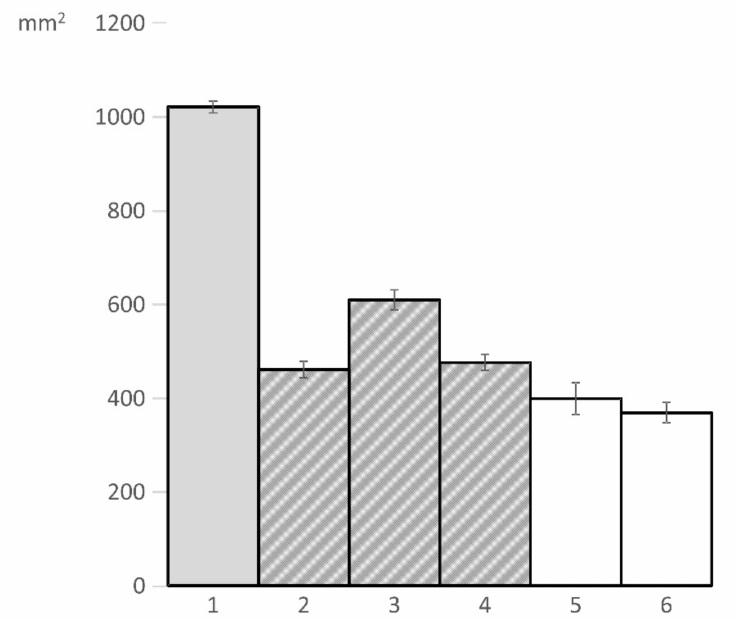
Figure 5. Pod size in selected sets of accessions taken from historic and 2020 data combined. Pod size is represented as the product of pod length and width in mm 2 . The sets are: (1) All accessions, n = 1735, (2) Structure subgroup 3.3, n = 45, (3) Peas from Afghanistan, n = 80, (4) Accessions Afghanistan within Structure subgroup 3.3, n = 28, (5) Structure subgroup 3.6, n = 18, (6) Pisum fulvum n = 16. One P. fulvum data point is not assigned to structure group 3.6 and two data points in structure group 3.6 are not assigned to P. fulvum . Structure subgroup assignments and named taxa are as in [12]. Error bars are standard